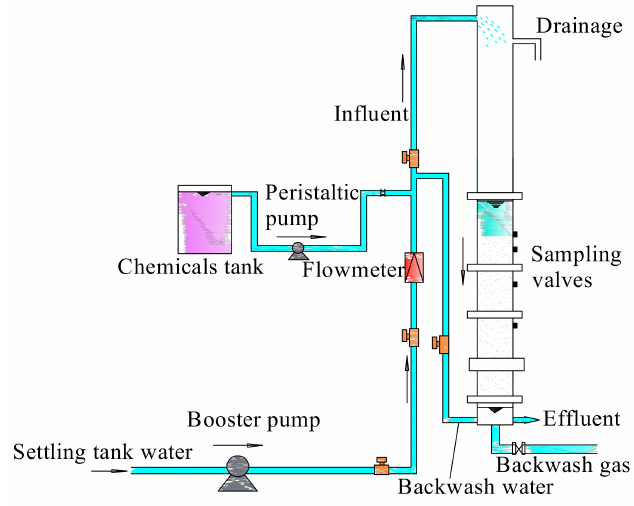
Figure 1. Schematic diagram of the pilot-scale experiment